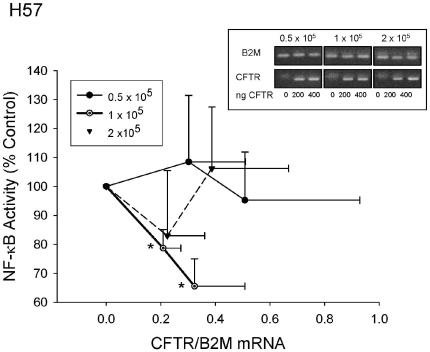
CFTR only reduces inflammation at a critical seeding density.
A. NF-κB activity (n = 5, *p<0.05, y-axis) in HeLa H57 cells seeded at varying densities (0.5×105, 1×105 and 2×105 cells per well; inset), transfected with increasing amounts of wt CFTR cDNA (0–400 ng), relative to empty vector (100% on y axis). The amount of CFTR mRNA for each transfection as described in methods was then analysed by real-time PCR (qPCR) (x axis and inset). The inset shows final PCR products from a typical qPCR run showing that there was no detectable CFTR mRNA prior to transfection with wt-CFTR vector.